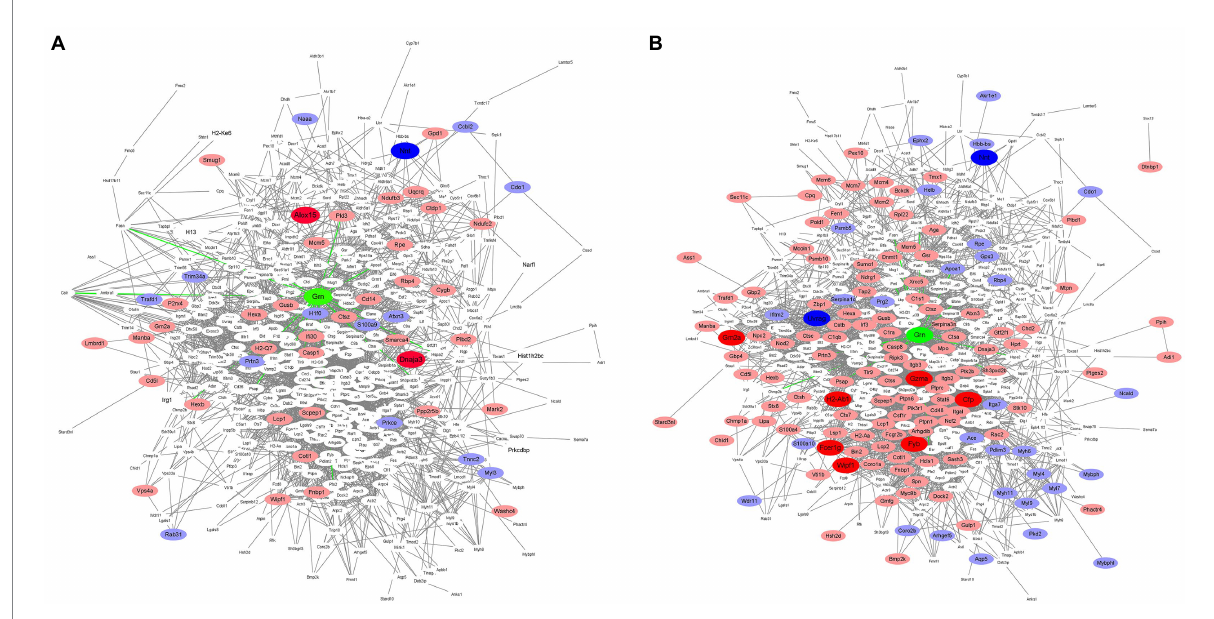
FIGURE 6 Protein interactions network. In the figure, green color indicates PGRN. Red color represents up-regulated proteins and blue indicates down- regulated proteins. Dark color represents the extremely significant changes, light color indicates the significant changes, and white represents no significant changes. (A) The protein–protein interactions of the DEPs in KO-d0 vs. WT-d0 group are analyzed by the STRING software. (B) The protein–protein interactions of the DEPs in KO-d3 vs. WT-d3 group after influenza virus infection are analyzed by the STRING